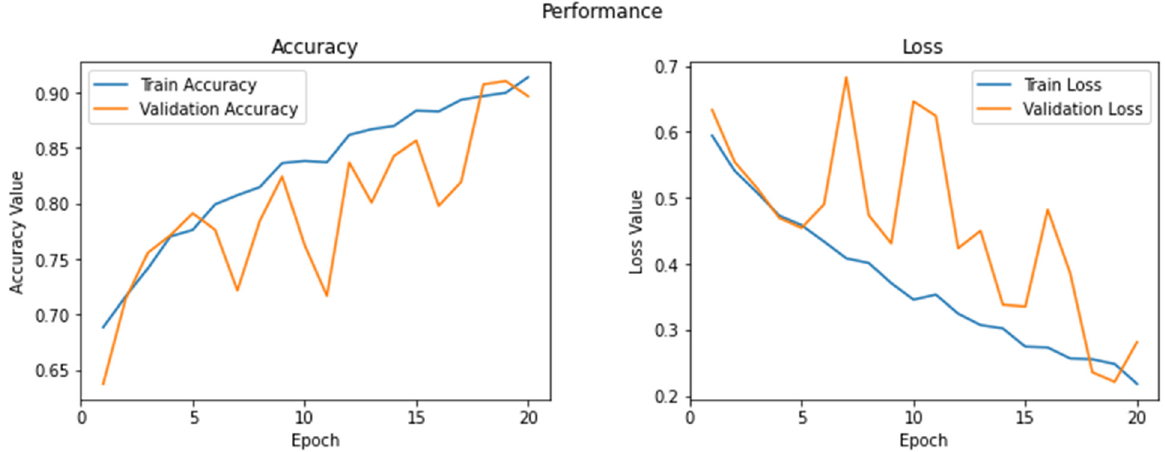
Figure 9. Accuracy plot and loss plot for qiskit.aer with ResNet34.